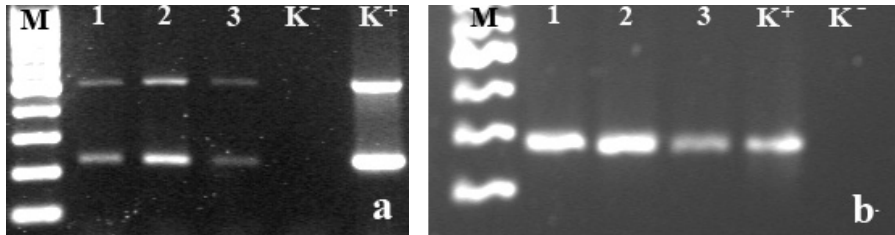
Figure 4. Gel electrophoresis analysis of polymerase chain reaction products amplified by duplex-PCR (a) and by RG-PCR (b) of pollen samples washed eight times and water used for washing without Tween 20; lane 1, washed pollen; lane 2, water collected after the first four washings (washing water); lane 3, water collected from the fifth to the eighth washing (washing water). K - , negative control (water); K + , bacterial suspension (10 8 cfu mL -1 ) of Pseudo- monas syringae pv. actinidiae CRAPAV-1530; M, molecular marker (Gene Ruler TM 100 pb DNA ladder, Fermentas,